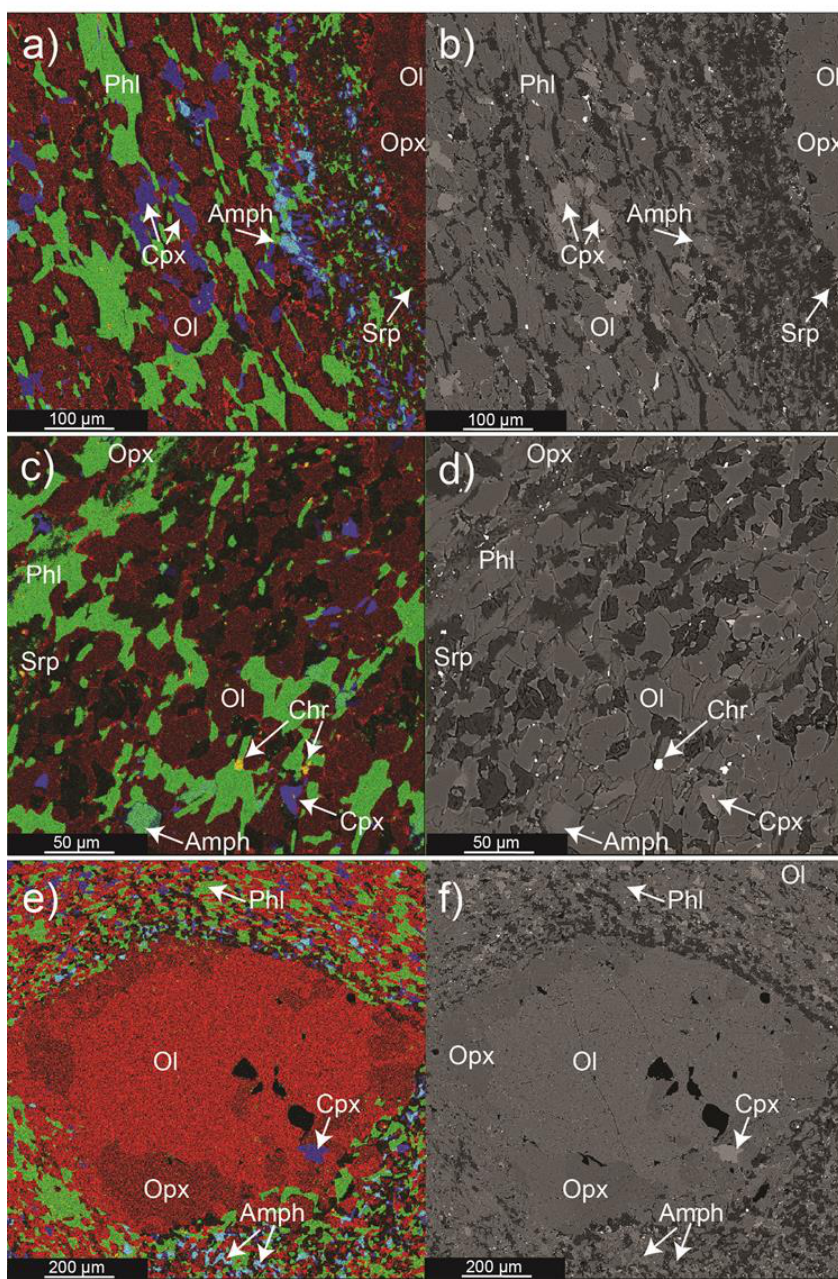
Figure 4. Red, green, and blue (RGB) compositional maps (left side) and BSE images (right side) showing the textures and major element distribution in mineral phases in mylonitic and ultramylonitic samples (30F, 30G, 30L). RGB map colours: Red=Fe; Green=Al and Blue=Ca. ( a – b ) texture variation in mylonite (30G) from olivine porphyroclast (on the right) to mylonitic matrix; ( c – d ) detail of ultramylonitic matrix (30F); ( e – f ) olivine porphyroclast embedded in the ultramylonitic matrix (30F).